Question: State the chart type depicted above.
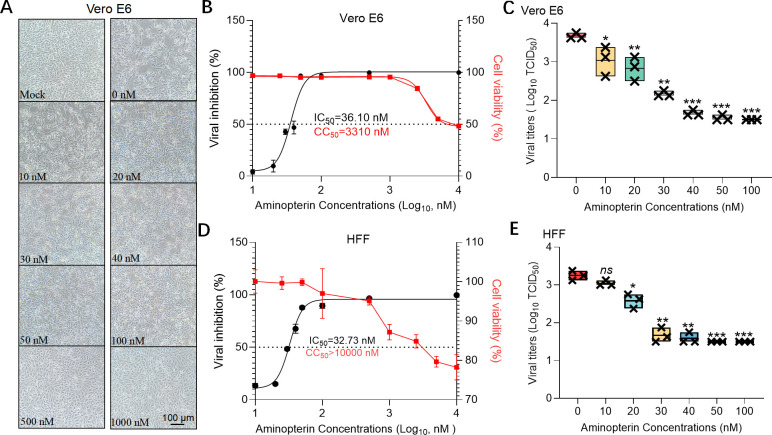
Answer: line